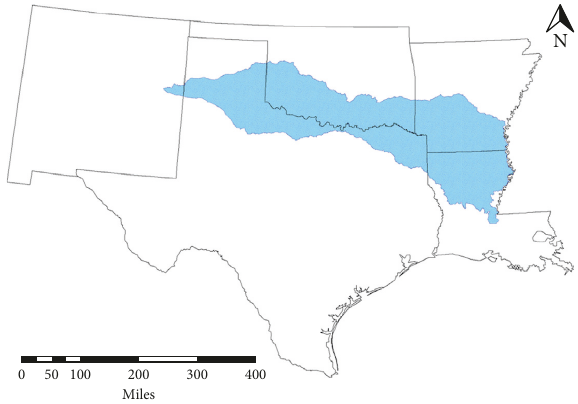
Figure 1: Red River